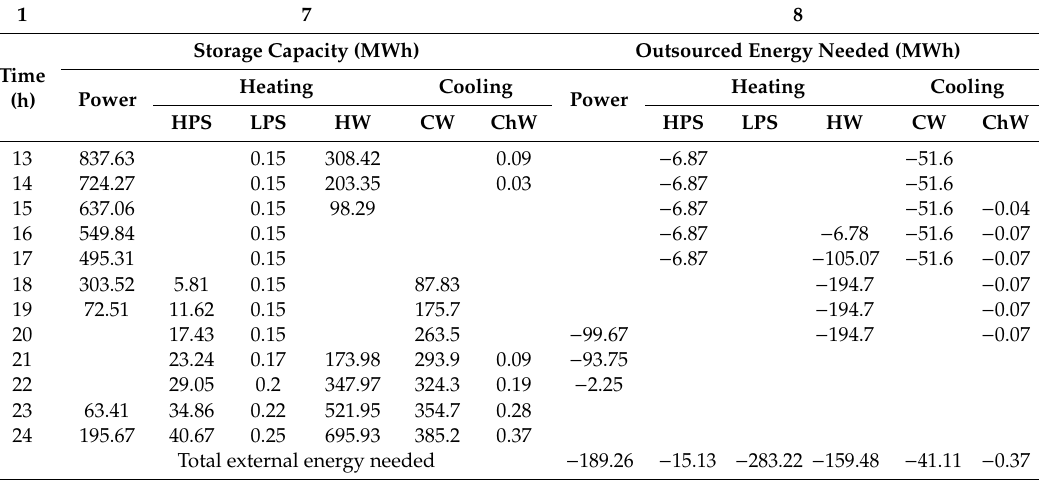
Table A28. TriGenSCT of final trigeneration PWR NPP without integration from time 13 to 24